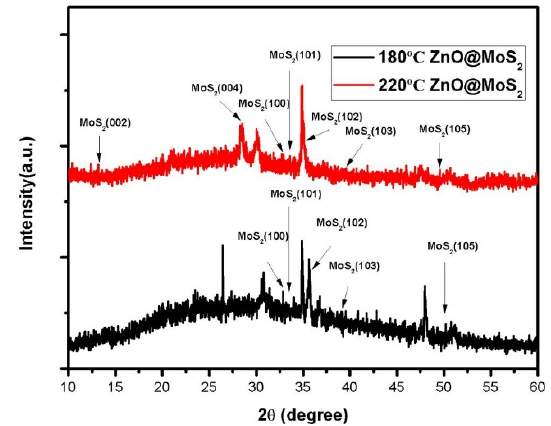
ff raction patterns of samples at 180 ◦ C and 220 ◦ Figure 3. X-ray diffraction patterns of samples at 180 °C and 220 °C Figure 3. X-ray diffraction patterns of samples at 180 °C and 220 °C Figure 3. X-ray di